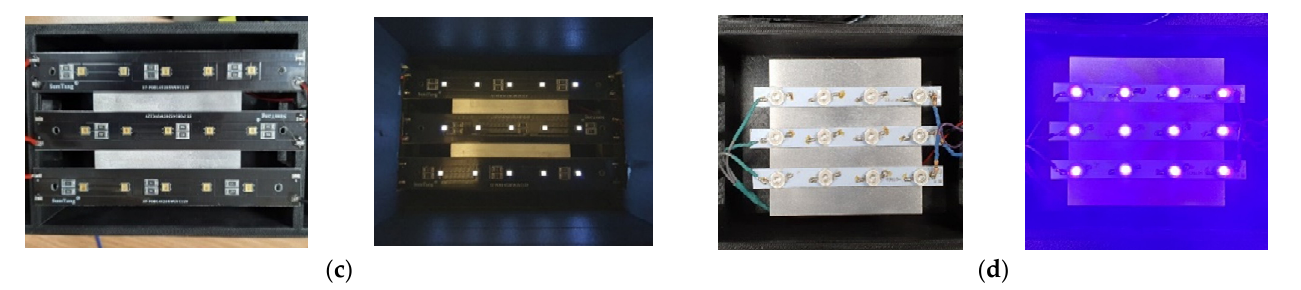
Figure 1. Components of the LED module used in this study. (a) The LED module concept diagram. ( b ) The actual module frame made with a 3D printer. ( c ) Array of the 275 nm LED attached to a heat sink. ( d ) Array of the 405 nm LED attached to a heat sink.